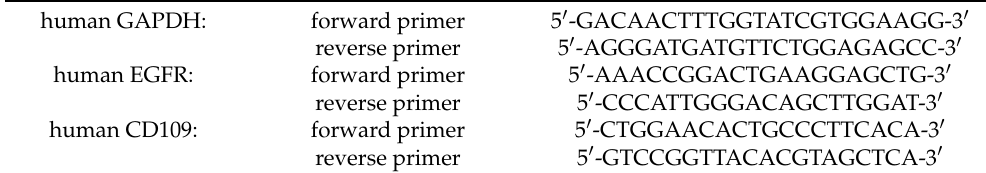
Table 1. Primer sets used for qPCR. human